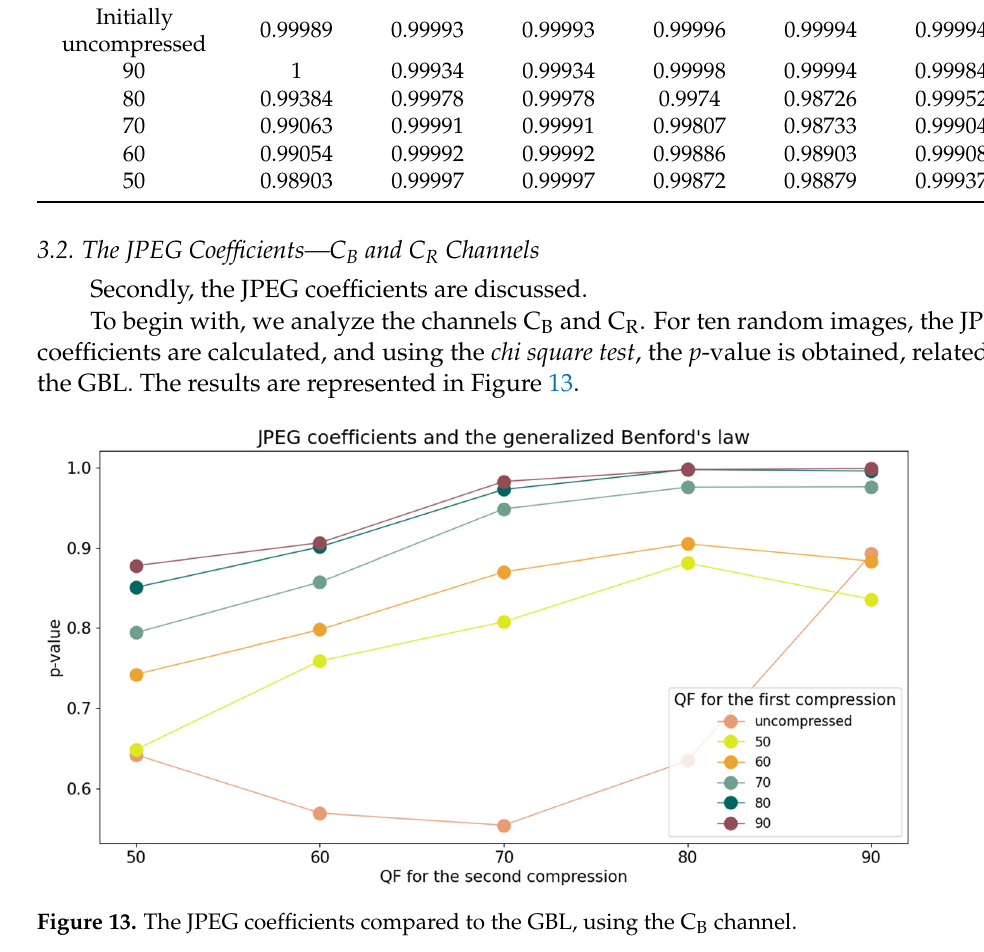
Table 3. Comparison between JPEG coefficients and the GBL for uncompressed images.